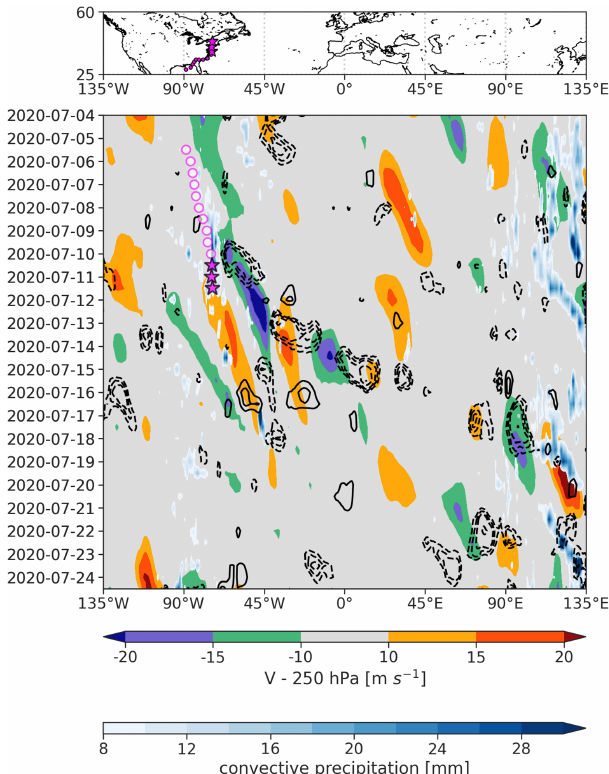
Figure 5. Hovmöller diagram of the 250hPa meridional wind (color shading, in ms − 1 ) for 4 to 24 July 2020 and the convective precip- itation averaged between 25 and 60 ◦ N. The black contours are the largest differences in the 48h forecast error in 500hPa geopotential between EXP_A and CTRL (dashed: negative, solid: positive). The magenta circles mark the position of Cyclone Fay; the stars high- light the onset of the ET and interaction with the midlatitude